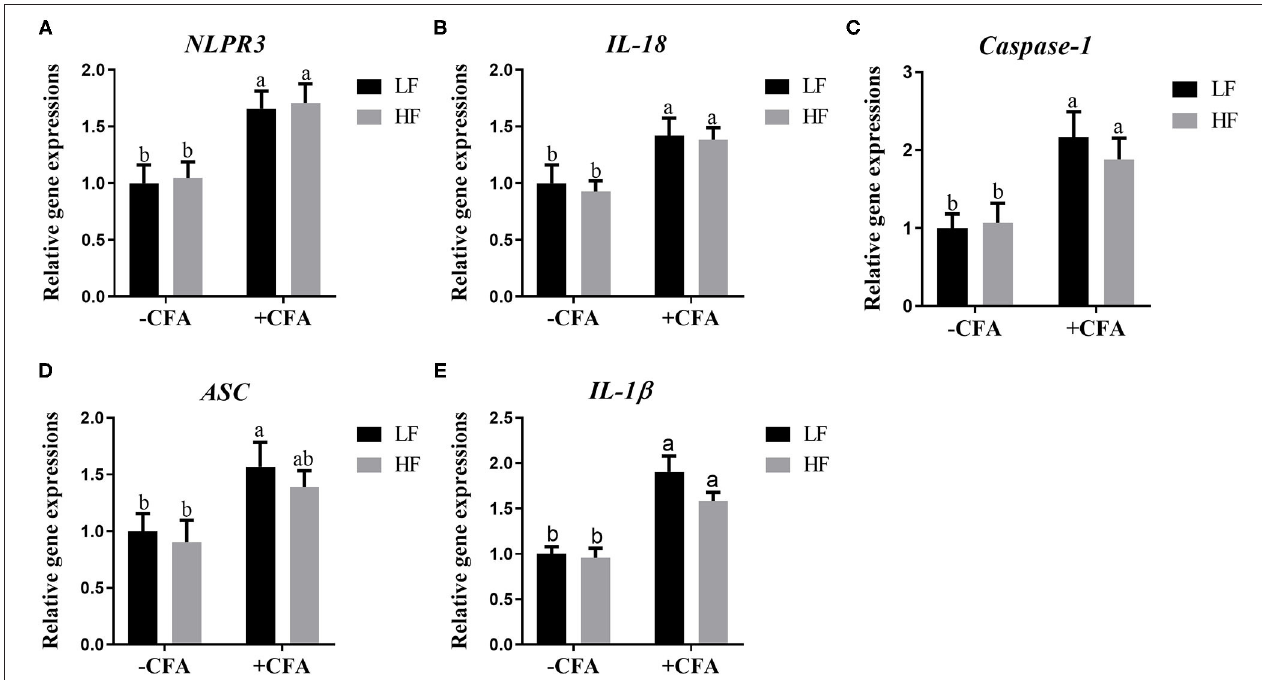
FIGURE 10 | Relative mRNA abundance in the lung of piglets fed diets supplemented with fiber following CFA challenge. (A) NLRP3, Nod-like receptor; (B) IL-18, Interleukin 18; (C) Caspase-1, Cysteine-requiring aspartate protease 1; (D) ASC, Apoptosis-associated speck-like protein containing a CARD; (E) IL-1 β , Interleukin 1 β . Values are means, with their standard errors represented by vertical bars. a,b Mean values with unlike letters were significantly different ( p <